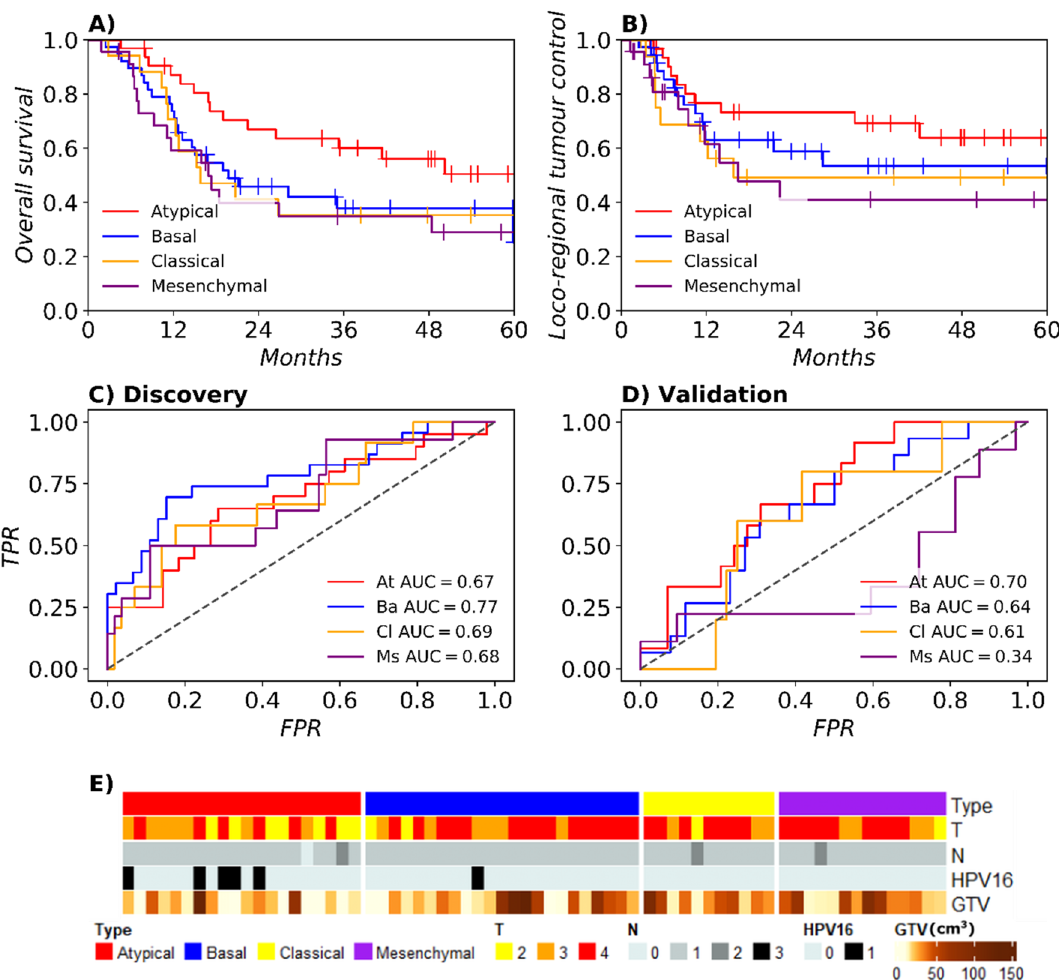
Figure 2. Outcome stratified by molecular subtypes and their classification using radiomics. Kaplan–Meier survival curves show that atypical tumours have the best prognosis for both OS ( A ) and LRC ( B ) with the other three subtypes having similar outcomes. The receiver-operating characteristics (ROC) curves with false positive rate (FPR) and true positive rate (TPR) show good AUC point-estimates in the discovery cohort ( C ). For the atypical subtype and to a lesser extent for the basal subtype, this performance is translated to the validation cohort ( D ). The associations of molecular subtypes with the clinical characteristics T stage, N stage, HPV16 status and gross tumour volume (GTV) are shown in ( E ) for the discovery cohort. Atypical tumours are smaller, have a lower T stage, and are more often HPV+.